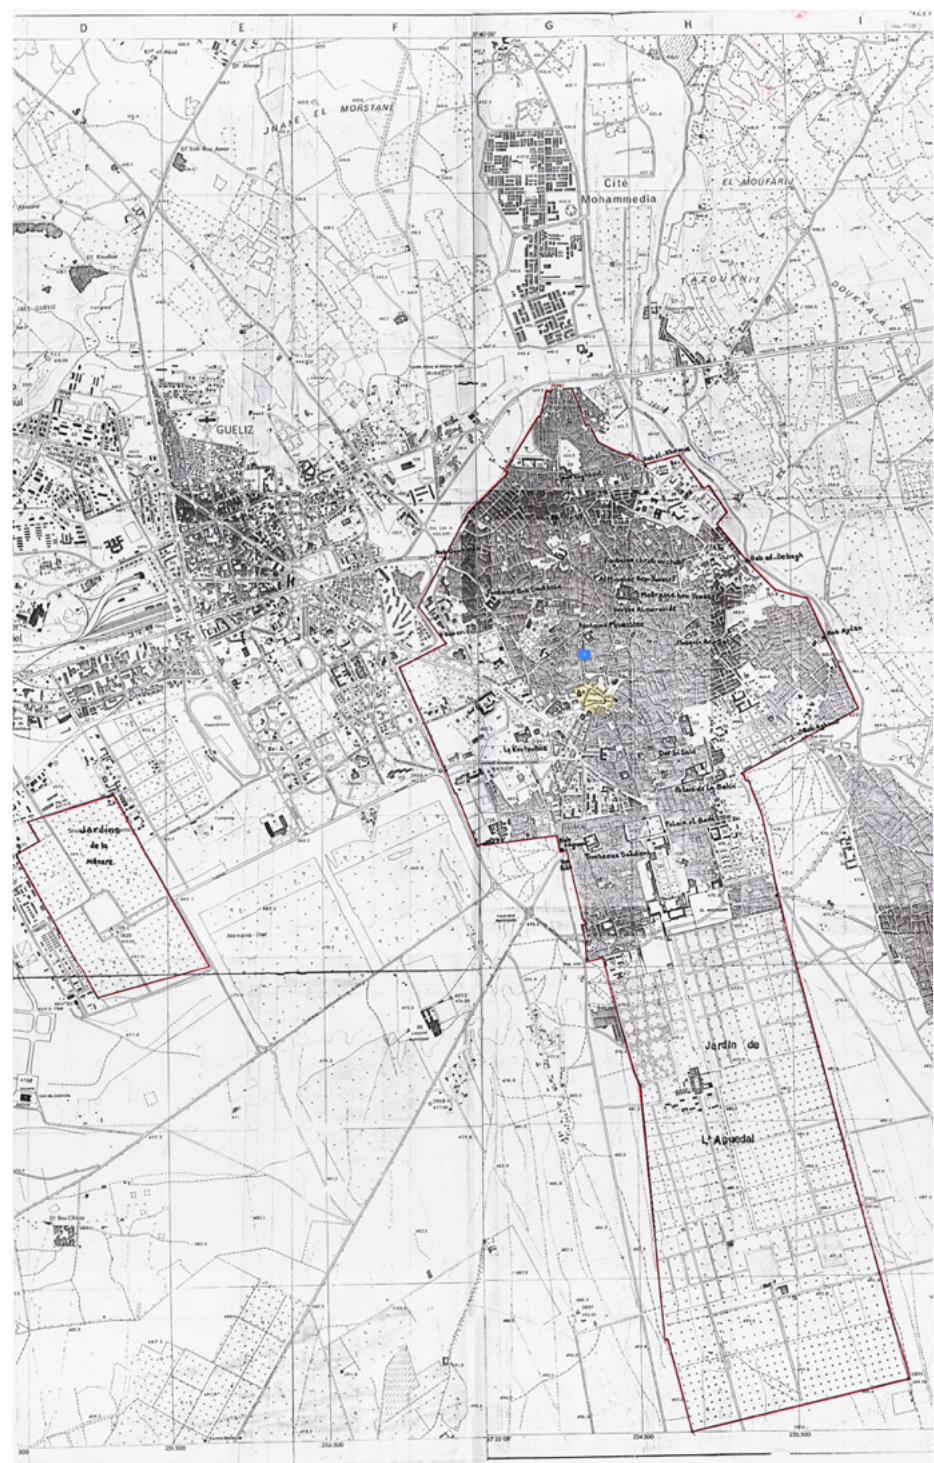
Figure 1: UNESCO map of the protected heritage zones in Marrakech